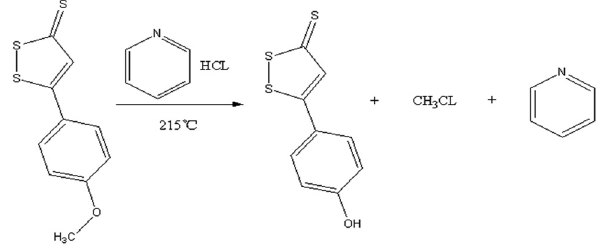
Figure A1: Reaction equation for the synthesis of ADT - OH compounds.